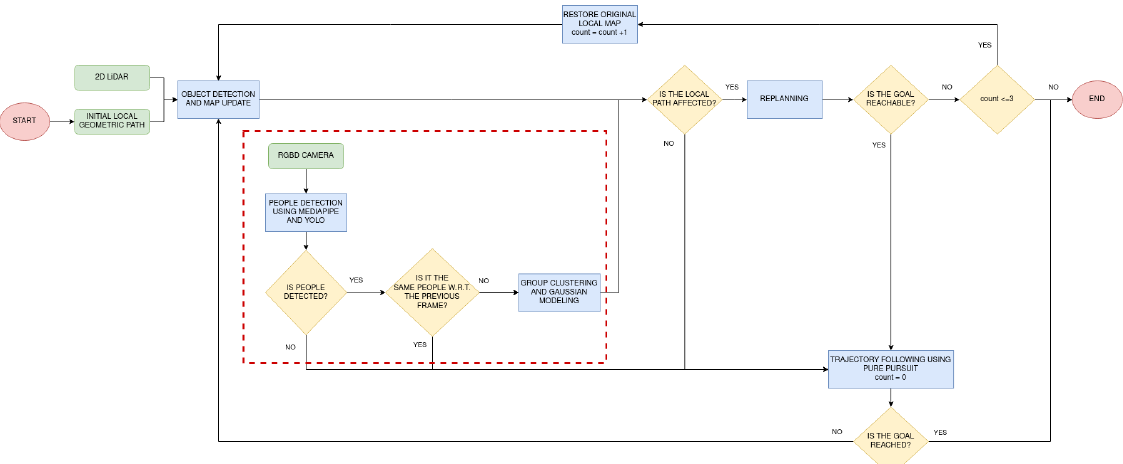
Figure 8. Modification of the plan following technique, marked with a red discontinuous rectangle. Camera data are used for locating people and modeling